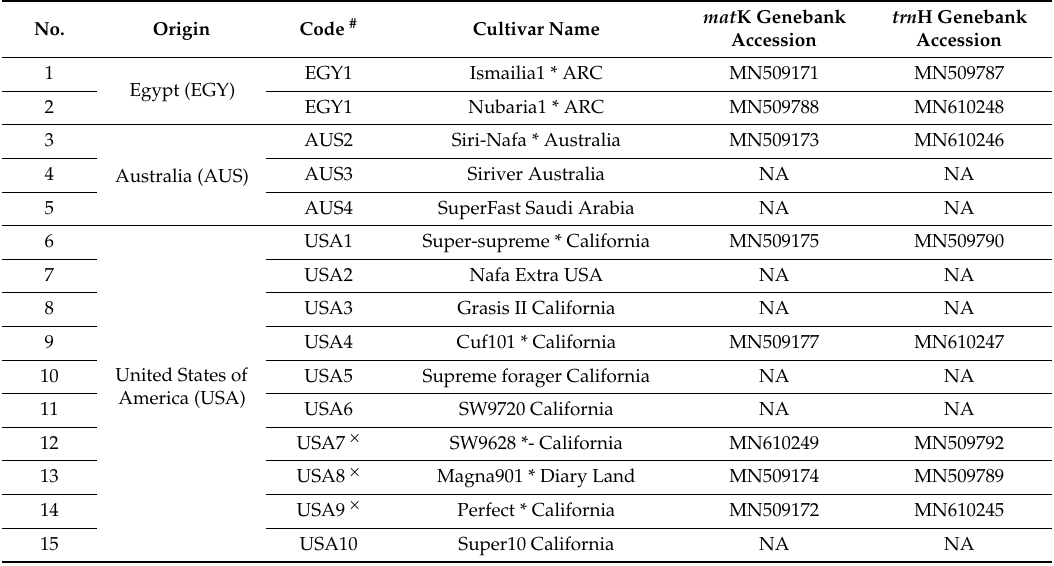
Table 1. Origin, codes, and names of the alfalfa cultivars as recorded by ICARDA and the Genebank deposited accession numbers for mat K and trn H genes for eight cultivars of Medicago sativa